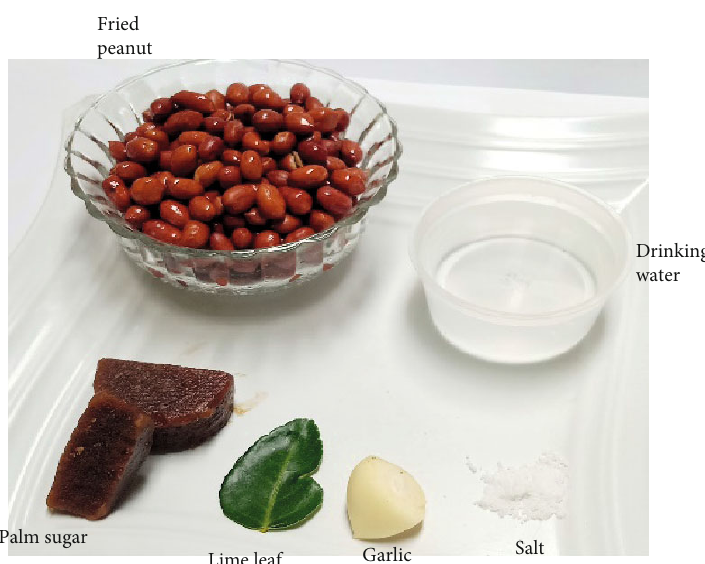
Figure 2: Peanut sauce ingredients: fried peanut, drinking water, garlic, lime leaf, and palm sugar.